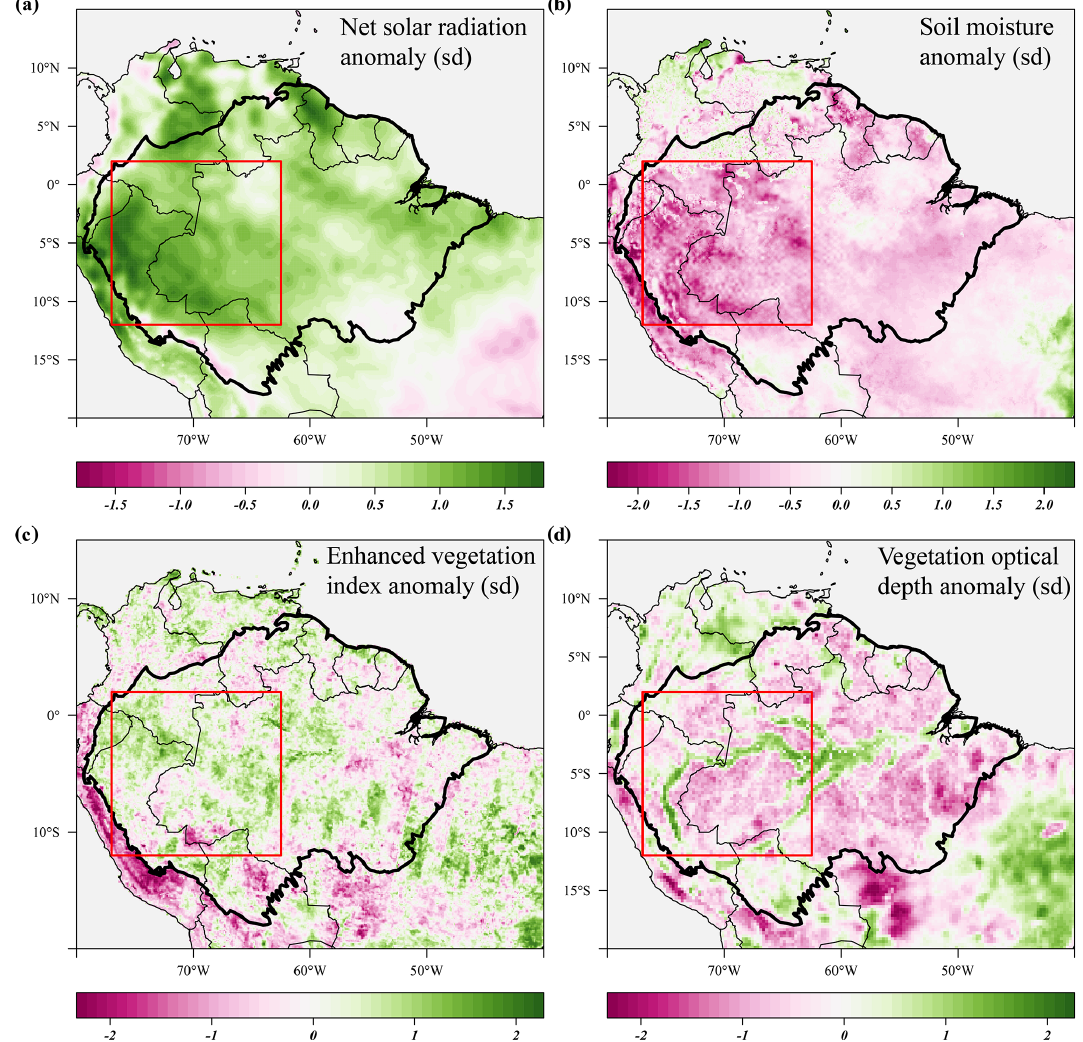
Figure 7. Seasonal anomalies in net solar radiation (a) , soil moisture (b) , enhanced vegetation index (c) and X-band vegetation optical depth (d) during the 2005 drought (June–September 2005) compared to their long-term monthly averages (1982–2019). Soil moisture anoma- lies are calculated from the ERA-5 volumetric soil moisture in the first soil layer (L1). Country borders and the extent of the Amazon basin are marked by thin and thick black lines, respectively. The red rectangle delineates the drought area for which further results are